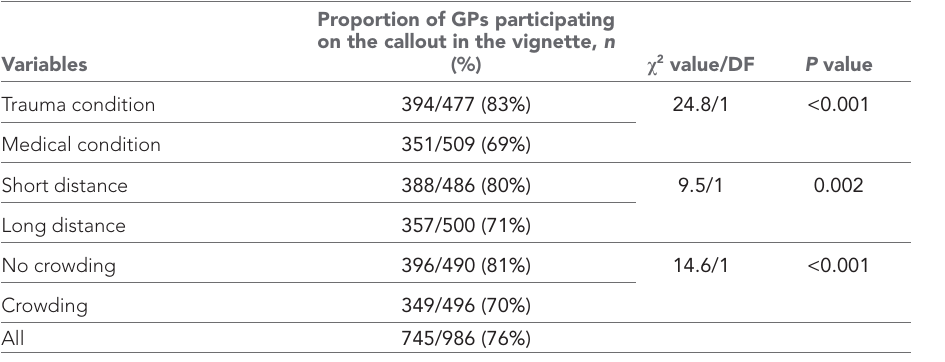
Table 4 Participation rate related to condition, distance, and crowding